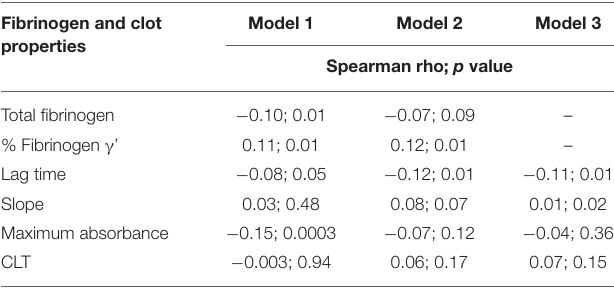
TABLE 2 | Correlations of 25(OH)D with total fibrinogen and γ ’ fibrinogen concentrations and plasma clot properties. Fibrinogen and clot